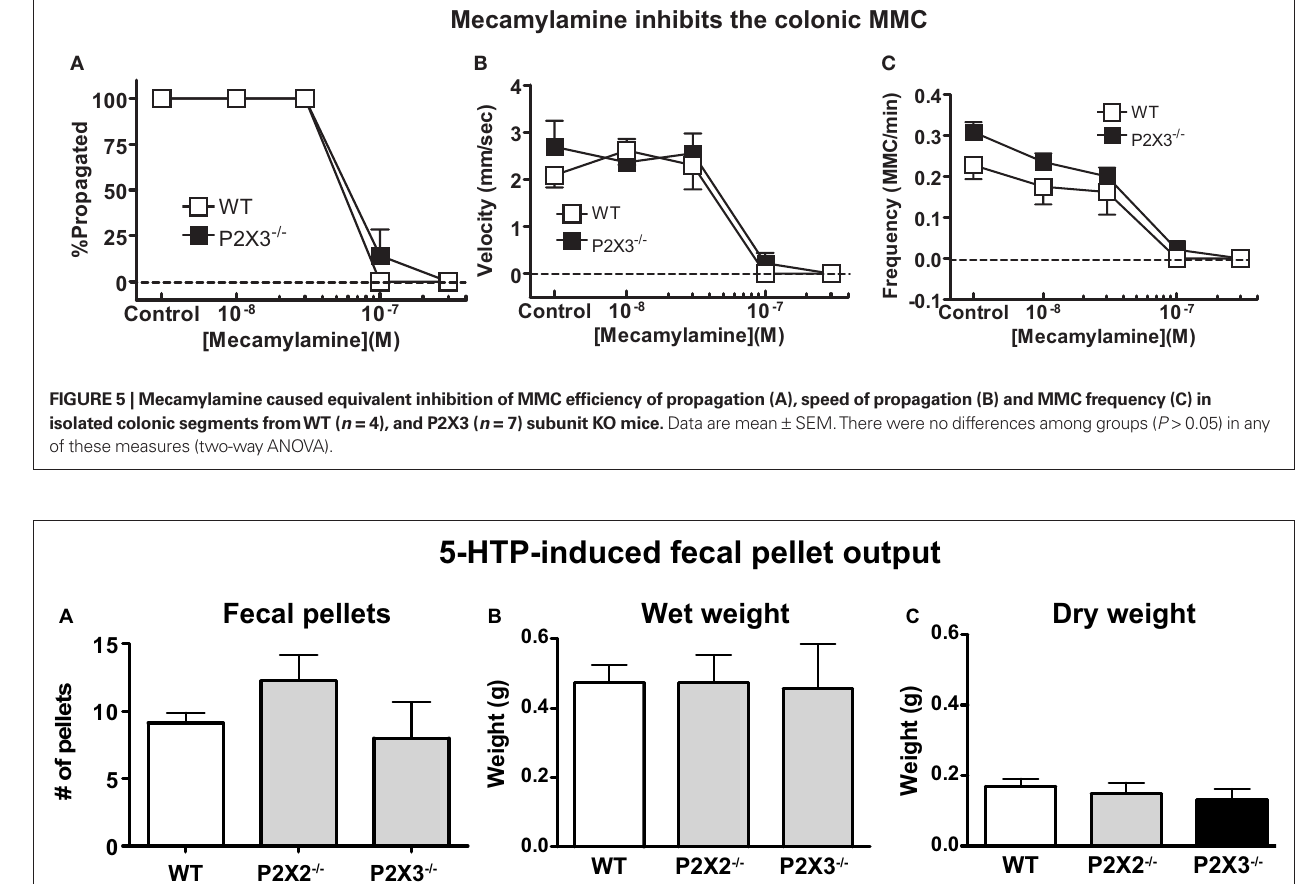
WT pellets expelled by each group. Data are mean ± SEM of the number of fecal pellets produced in the 60-min period after 5-HTP injection (100 mg/kg, i.p.). There were no differences among groups ( P > 0.05, one-way